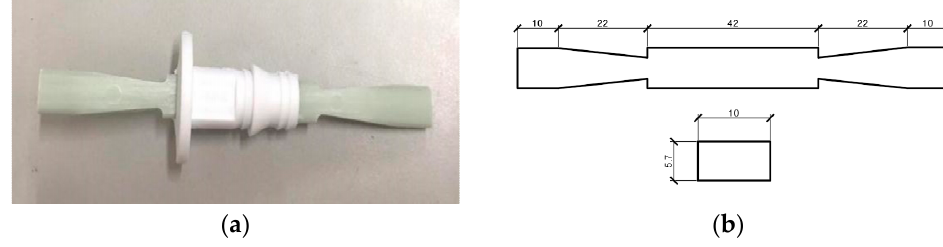
Figure 4. L1 connector. ( a ) Real image; ( b ) size details (mm). Figure 5. L2 connector. ( a ) Real image; ( b ) size detail (mm). Table 4. Material properties of connectors.